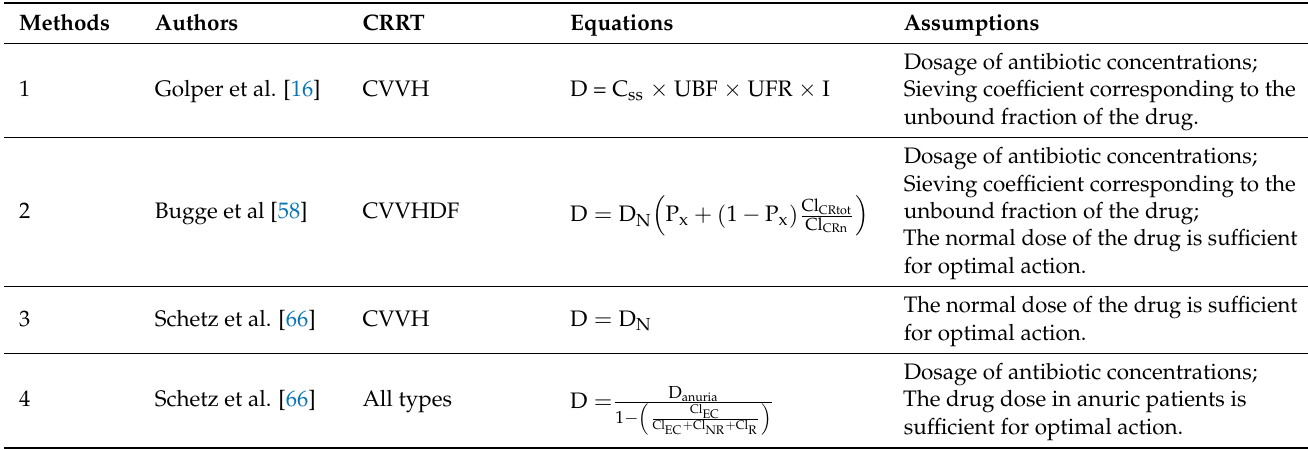
Table 5. Methods for estimating antibiotic dosage in